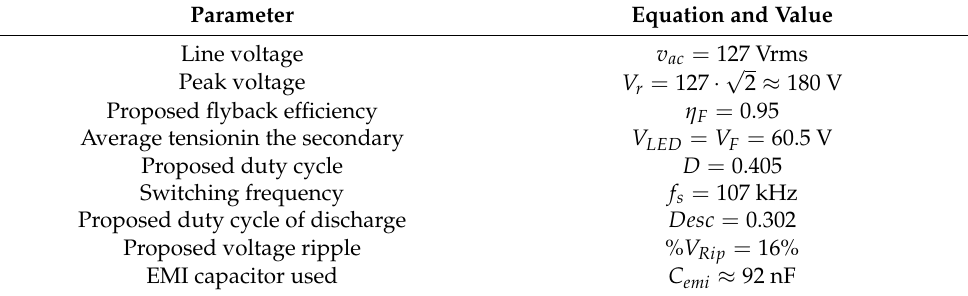
Table 3. Design parameters proposed.